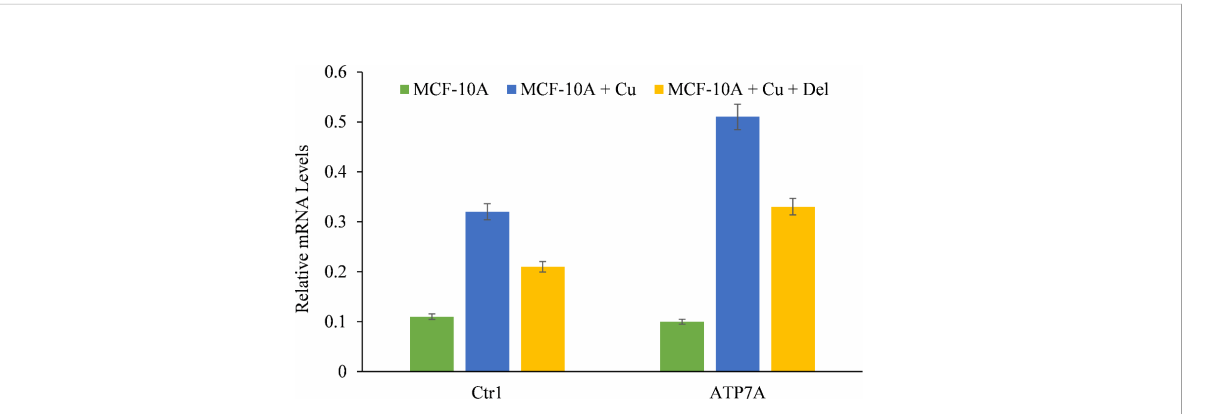
FIGURE 8 The effect of delphinidin on the elevated mRNA transcript levels of copper transporters Ctr1 and ATP7A in MCF-10A-Cu cells compared to their parental MCF-10A cells. TRIzol (Invitrogen) was used to isolate total RNA in accordance with the manufacturer ’ s instructions. As described in “ Methods, ” Ctr1 and ATP7A mRNA expression was quanti fi ed using real-time PCR. The values reported are the S.E. of three separate trials. p ≤ 0.01 when compared to respective untreated control was treated as signi fi